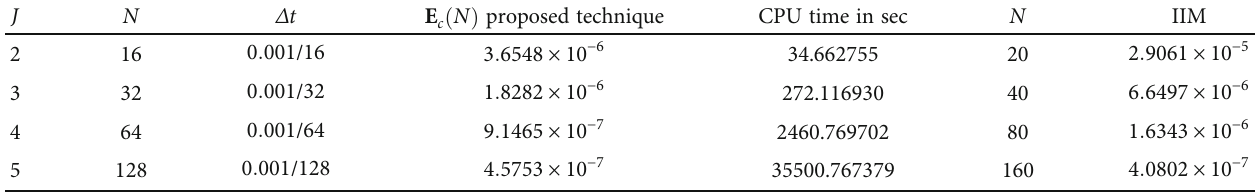
Table 5: Analysis of errors for Example 5.